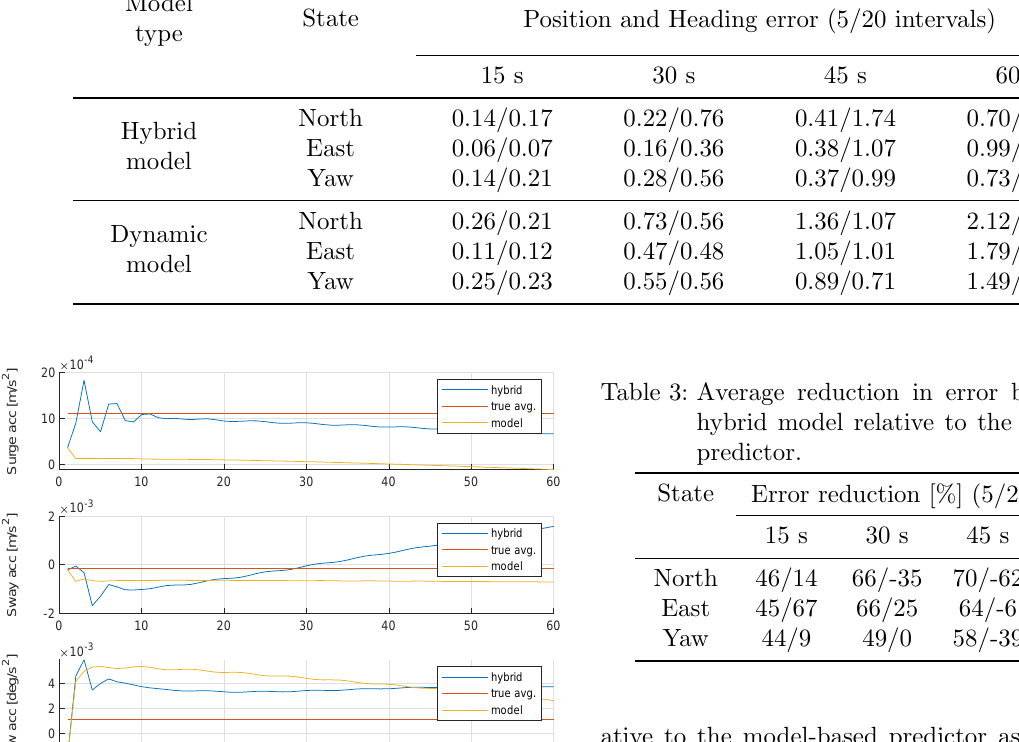
Table 2: Average errors in terms of North/East position and yaw angle for the first 5 and 20 prediction intervals after the power failure.